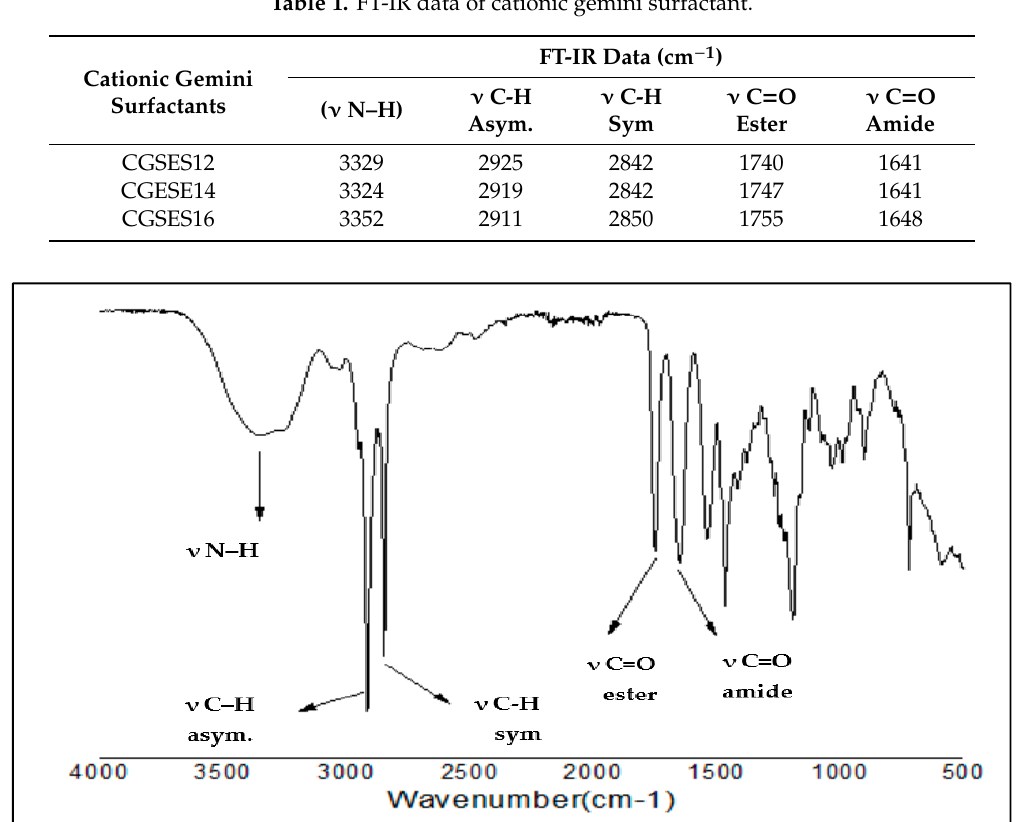
Figure 1. FT-IR spectrum for CGSES14.